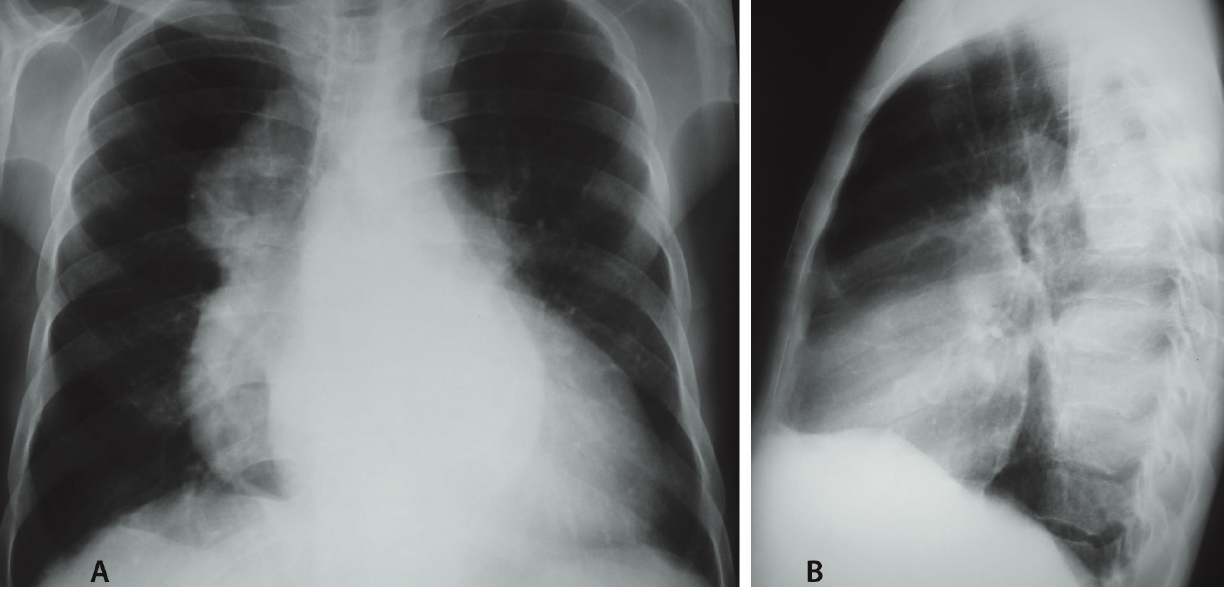
Fig. 2. Computed tomography scans with lung window (A) and mediastinal window (B) settings show bilateral masses in the inferior paravertebral thoracic regions. The masses were heterogeneous, with low-density areas suggesting a fatty